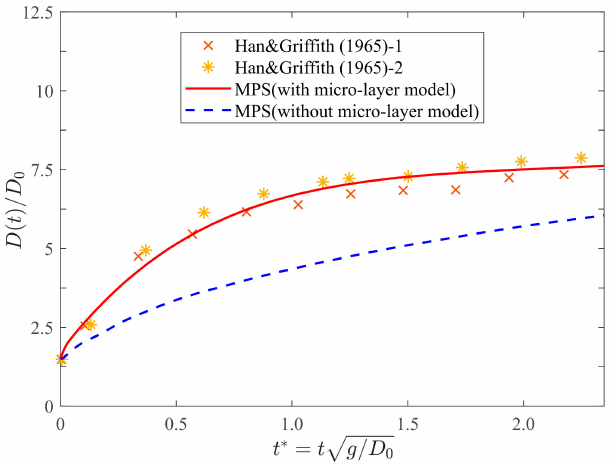
Figure 9. Comparison of the bubble growth rate between numerical simulations and Han and Griffith’s experimental results [4].